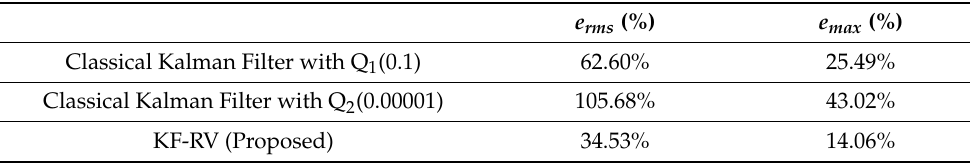
Table 1. Comparison of the estimation